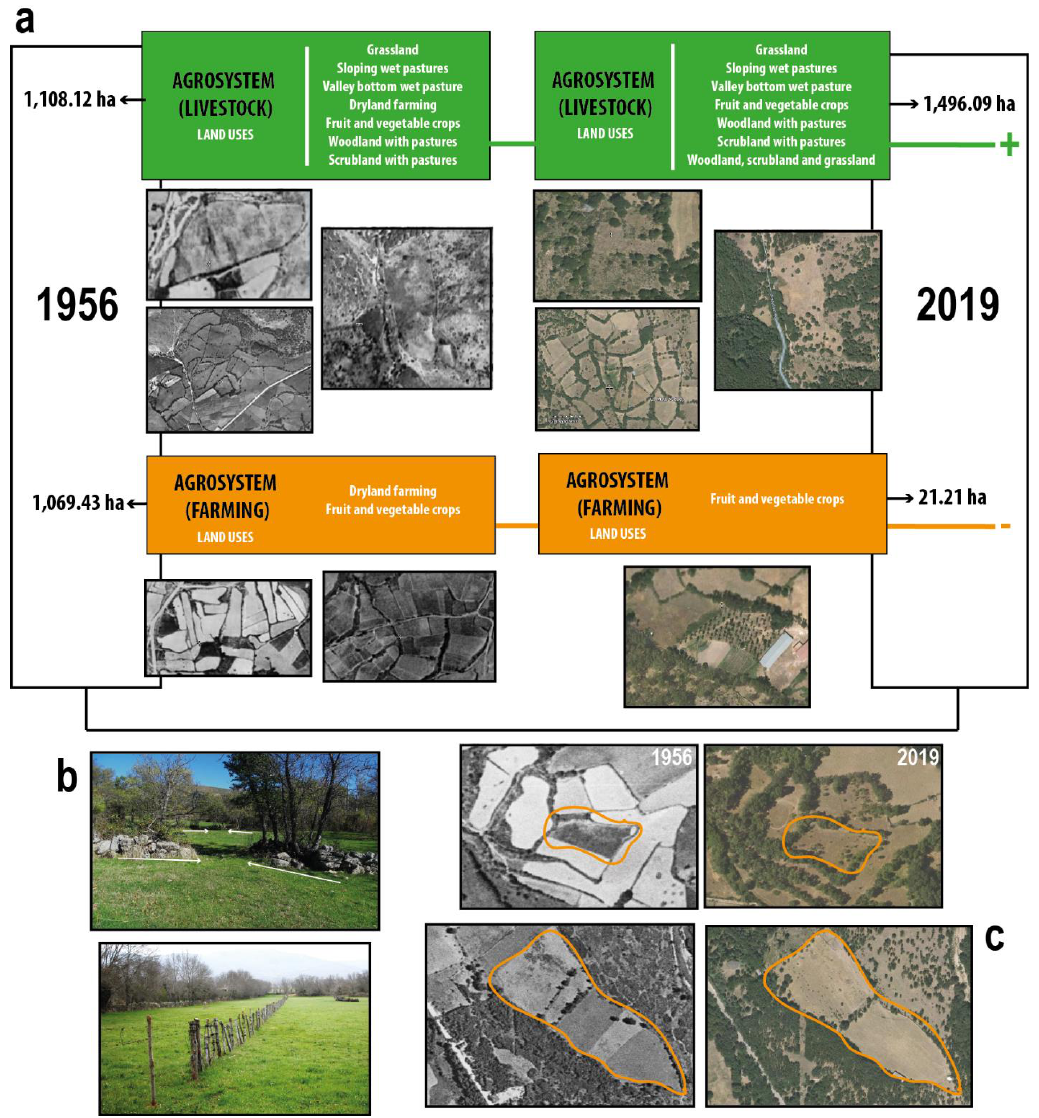
Figure 7. Agrosystem types and land uses ( a ) and examples of the transformation dynamics of land parcels: Bustarviejo, destruction of enclosures to facilitate the extensive passage of bovine livestock among parcels ( b ); Rascafría, division of land parcels due to inheritance partitions ( c ).